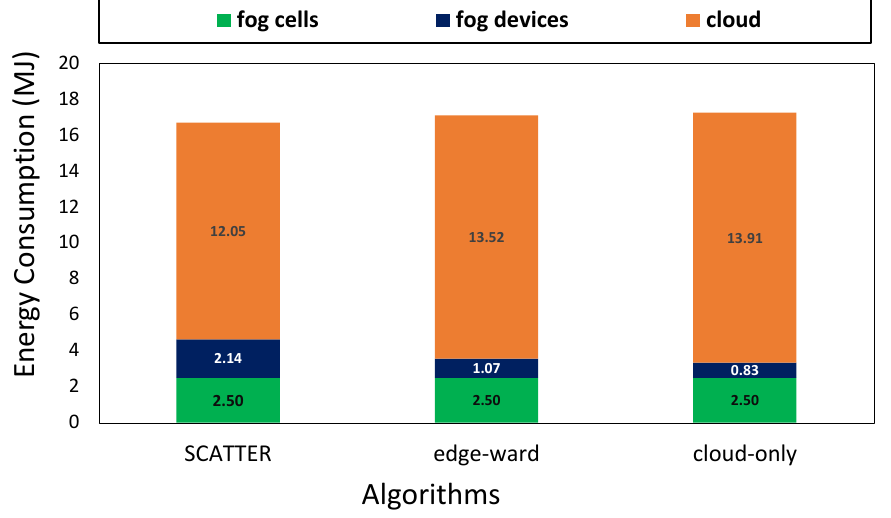
Figure 7. Energy consumption of devices in three